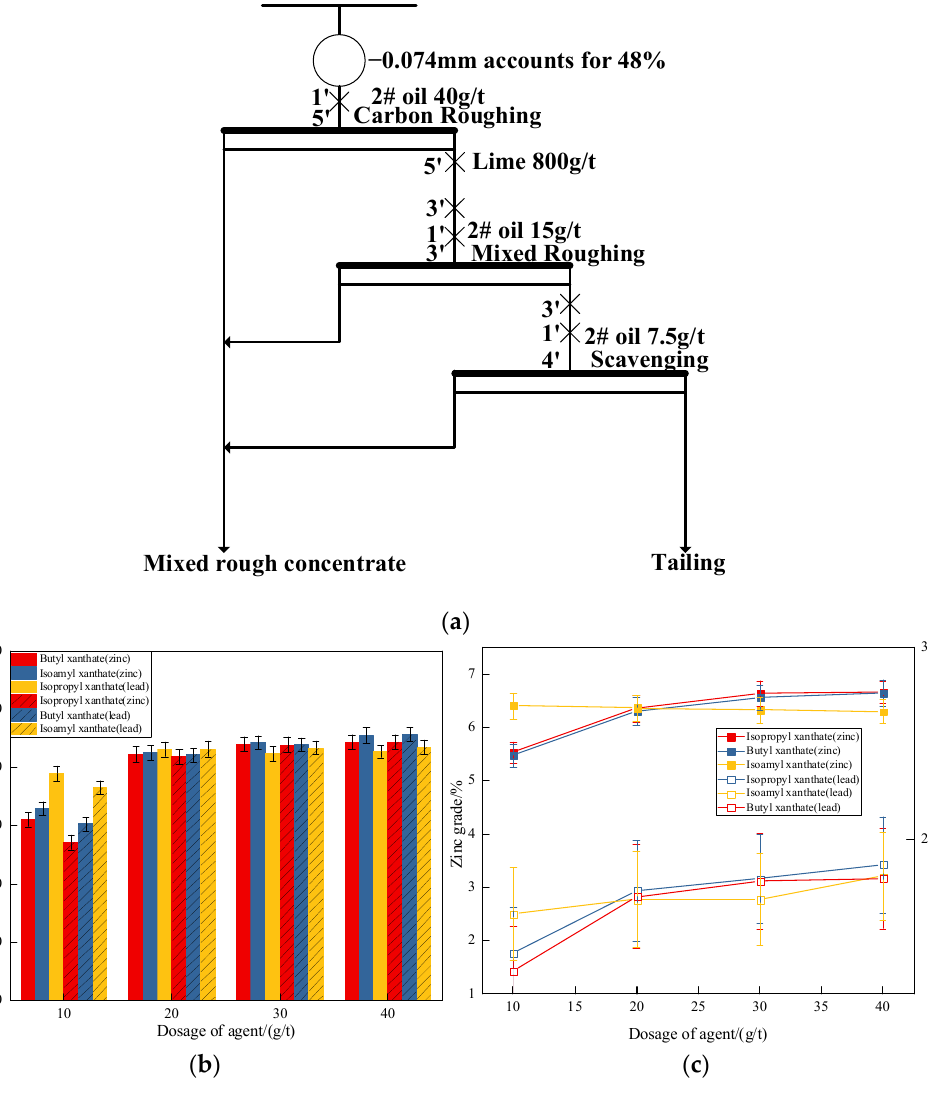
Figure 10. Effects of collector type and dosage on sulfide aggregates. ( a ) The flowsheet for flotation experiments; ( b ) effects of collector type and dosage on the recovery of sulfide aggregates; ( c ) effects of collector type and dosage on the grade of sulfide aggregates.